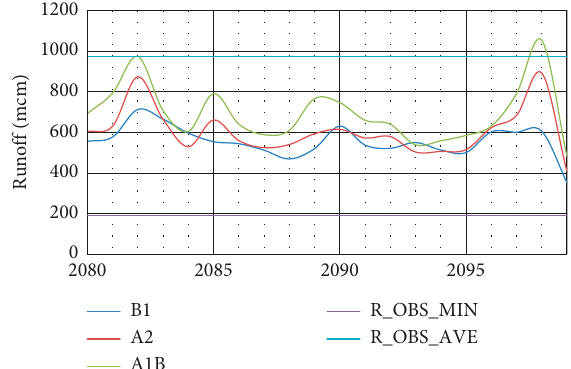
Figure 16: Comparison of the minimum and average observational runoff and the future far period under ensemble model and the three emission